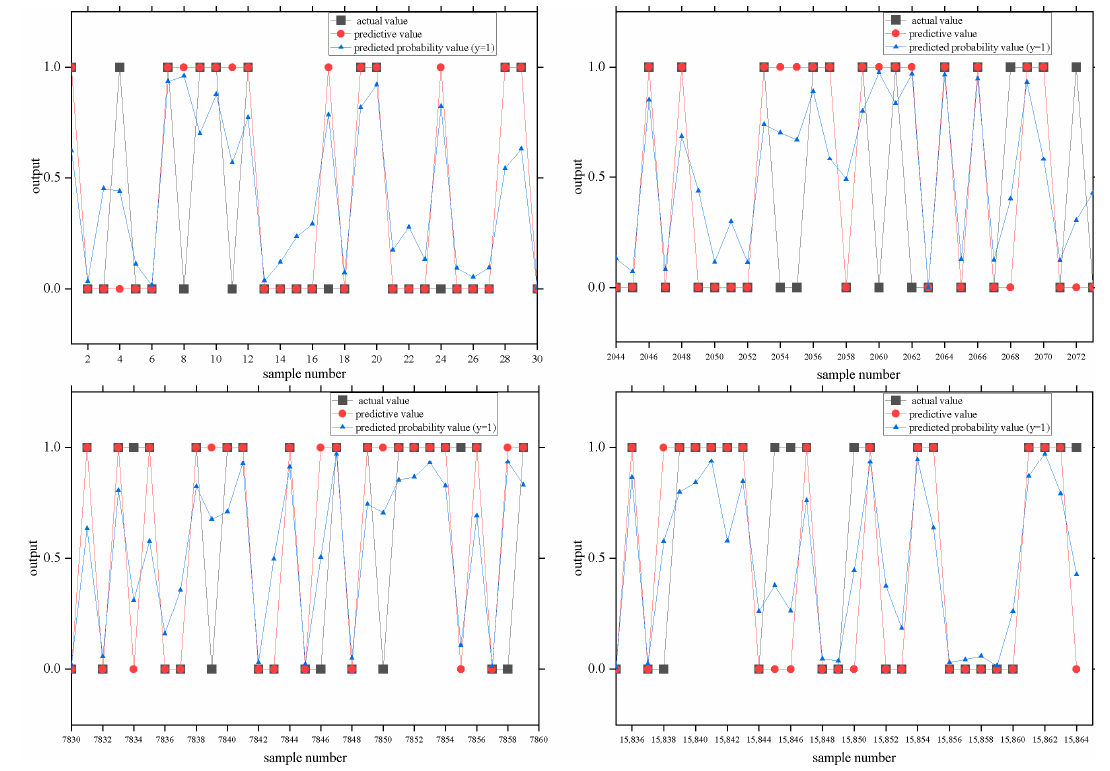
Figure 4. Comparison charts of the predictive and actual values of the ANN.